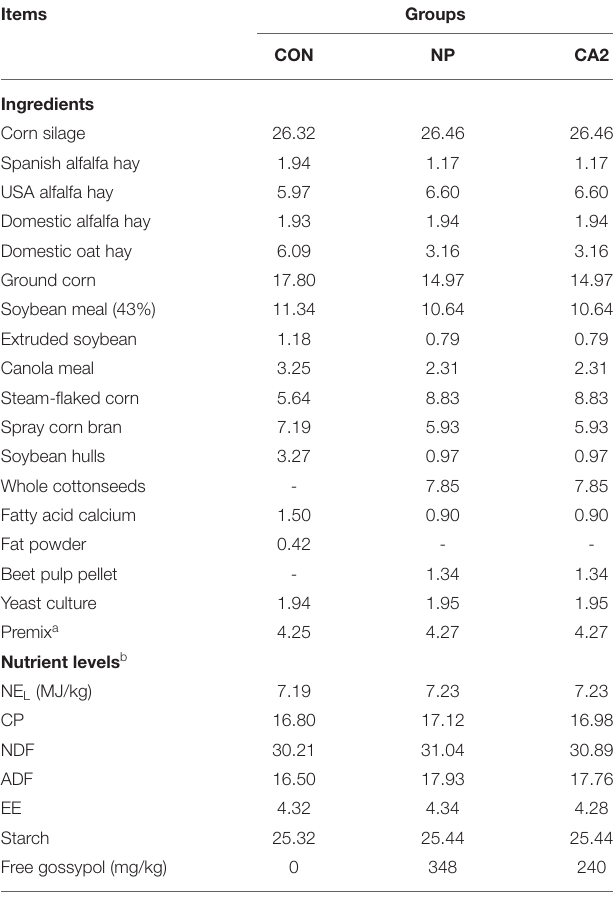
TABLE 2 | Chemical composition and nutrient levels of the basal diet (% DM basis).